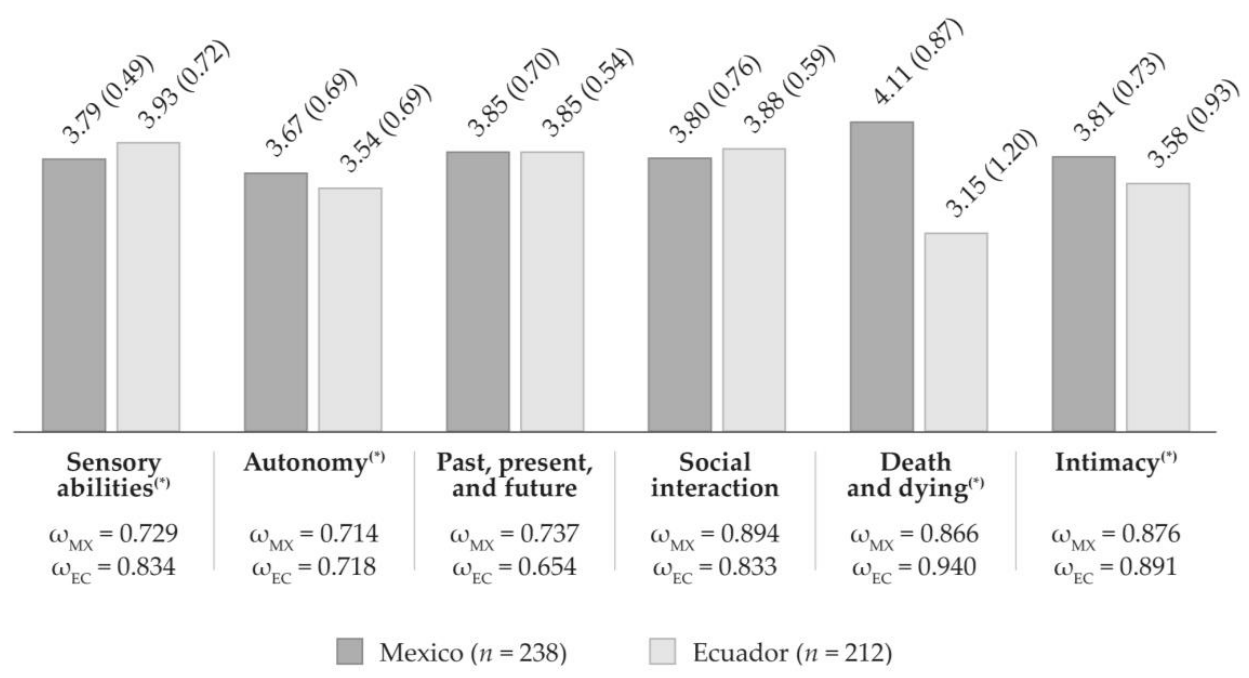
Figure 1. Descriptive statistics and composite reliability estimates of the WHOQOL-OLD dimensions among countries.